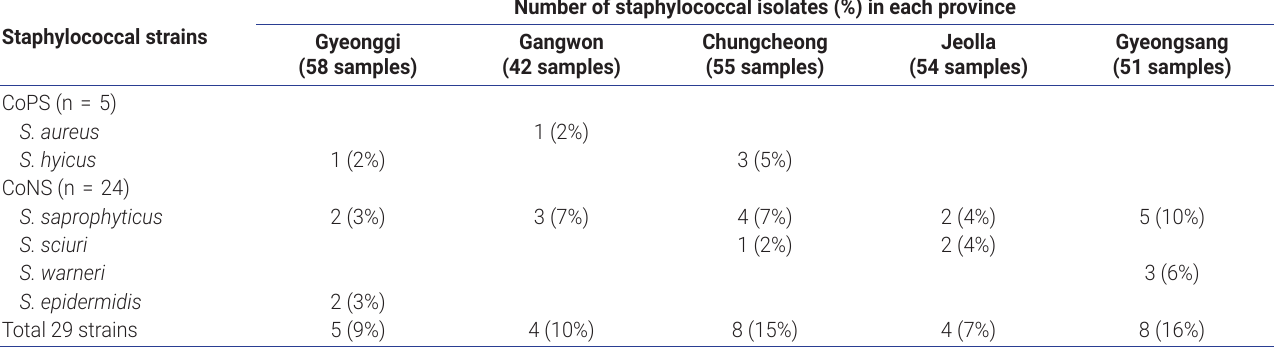
Table 2. Prevalence of CoPS and CoNS in pork meat samples Staphylococcal